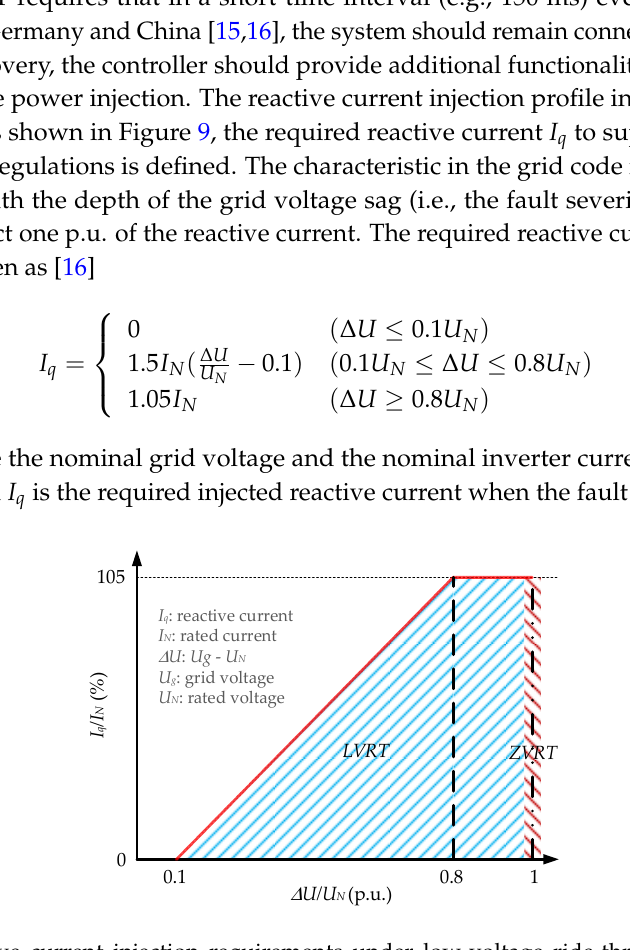
Figure 9. Reactive current injection requirements under low-voltage ride-through/zero-voltage ride- through (LVRT/ZVRT) operations in China [16].